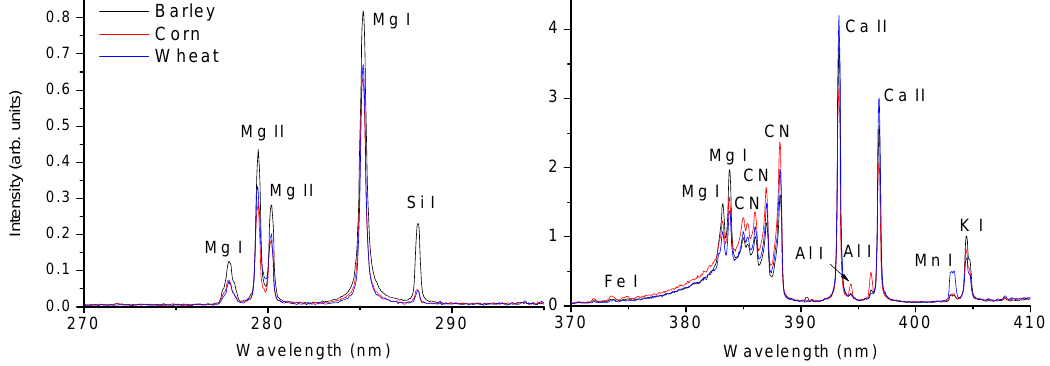
Figure 5. An example of FIBS spectra in the ranges of 270–295 nm and 370–410 nm obtained from the barley, corn and wheat grain dusts with the delay of t = 60 ns with respect to the laser pulse on the target (t = 0). Laser pulse energy was 7 mJ and the ICCD gate width was 2 µs. The Mn, Si, and Al lines resulting from the three samples show a large difference in signal